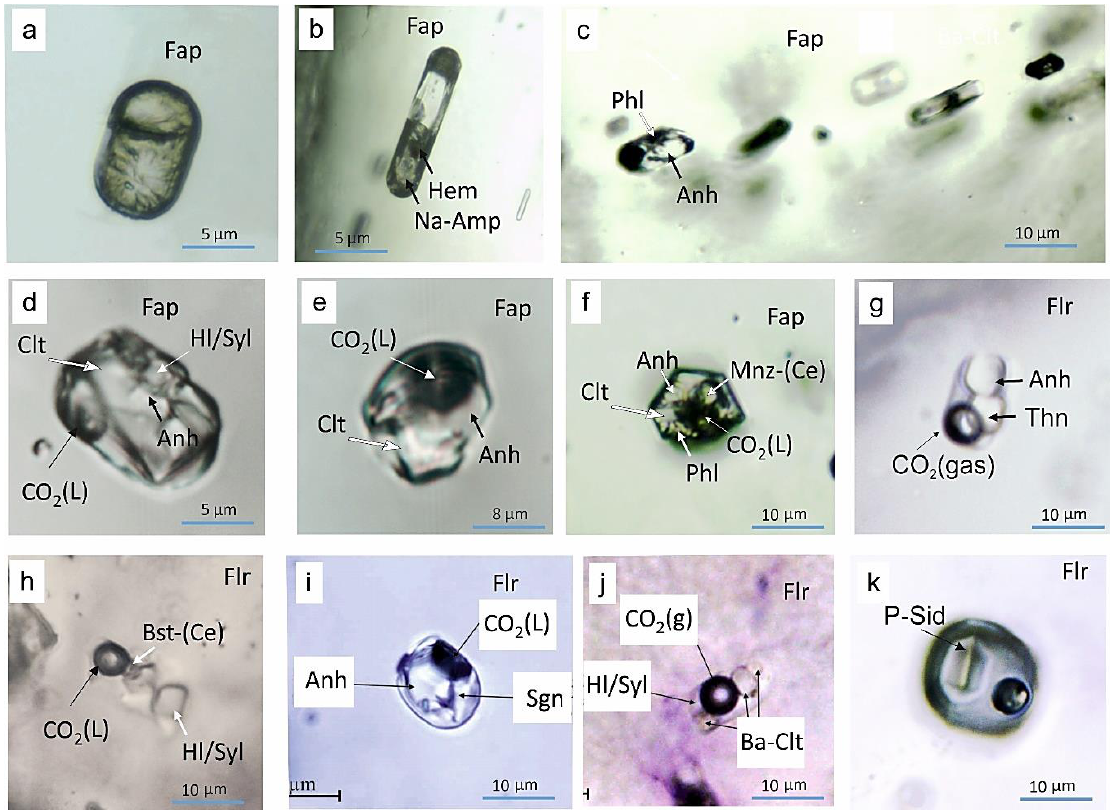
Figure 4. Melt inclusions of the Mushugai-Khudag alkaline complex, including melt of Ca-P-K-